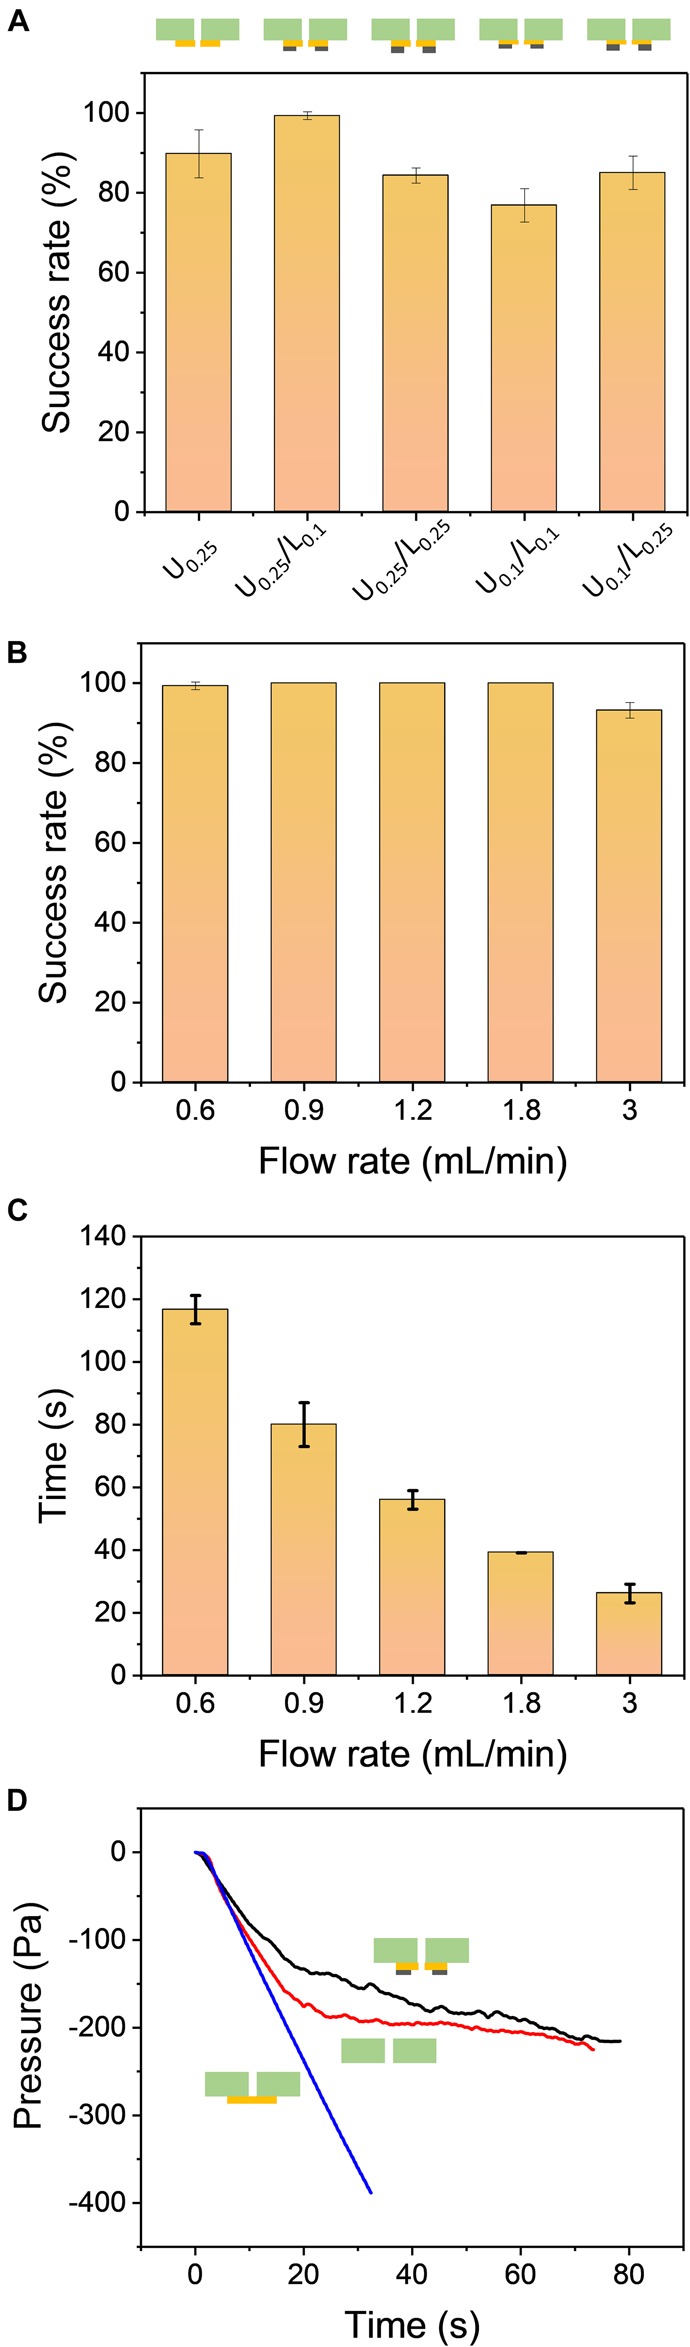
(A) The comparison of the hanging drop formation success rate using five different combinations of the holding layers: U0.25, U0.25/L0.1, U0.25/L0.25, U0.1/L0.1, U0.1/L0.25. The flow rate of air withdrawal was set to 0.9 mL/min. (B) The comparison of the success rate for different flow rates. The design of the holding layer was U0.25/L0.1. (C) The processing time of hanging drop formation when using various flow rates. All results were repeated three times (N = 3). (D) The internal pressure of the air chamber during operation of the PANDA system at different holding conditions: sealed holding layer (blue line), without holding layer (red line), and U0.25/L0.1 design of the holding layer (black line). The flow rate of air withdrawal was set to 0.9 mL/min.